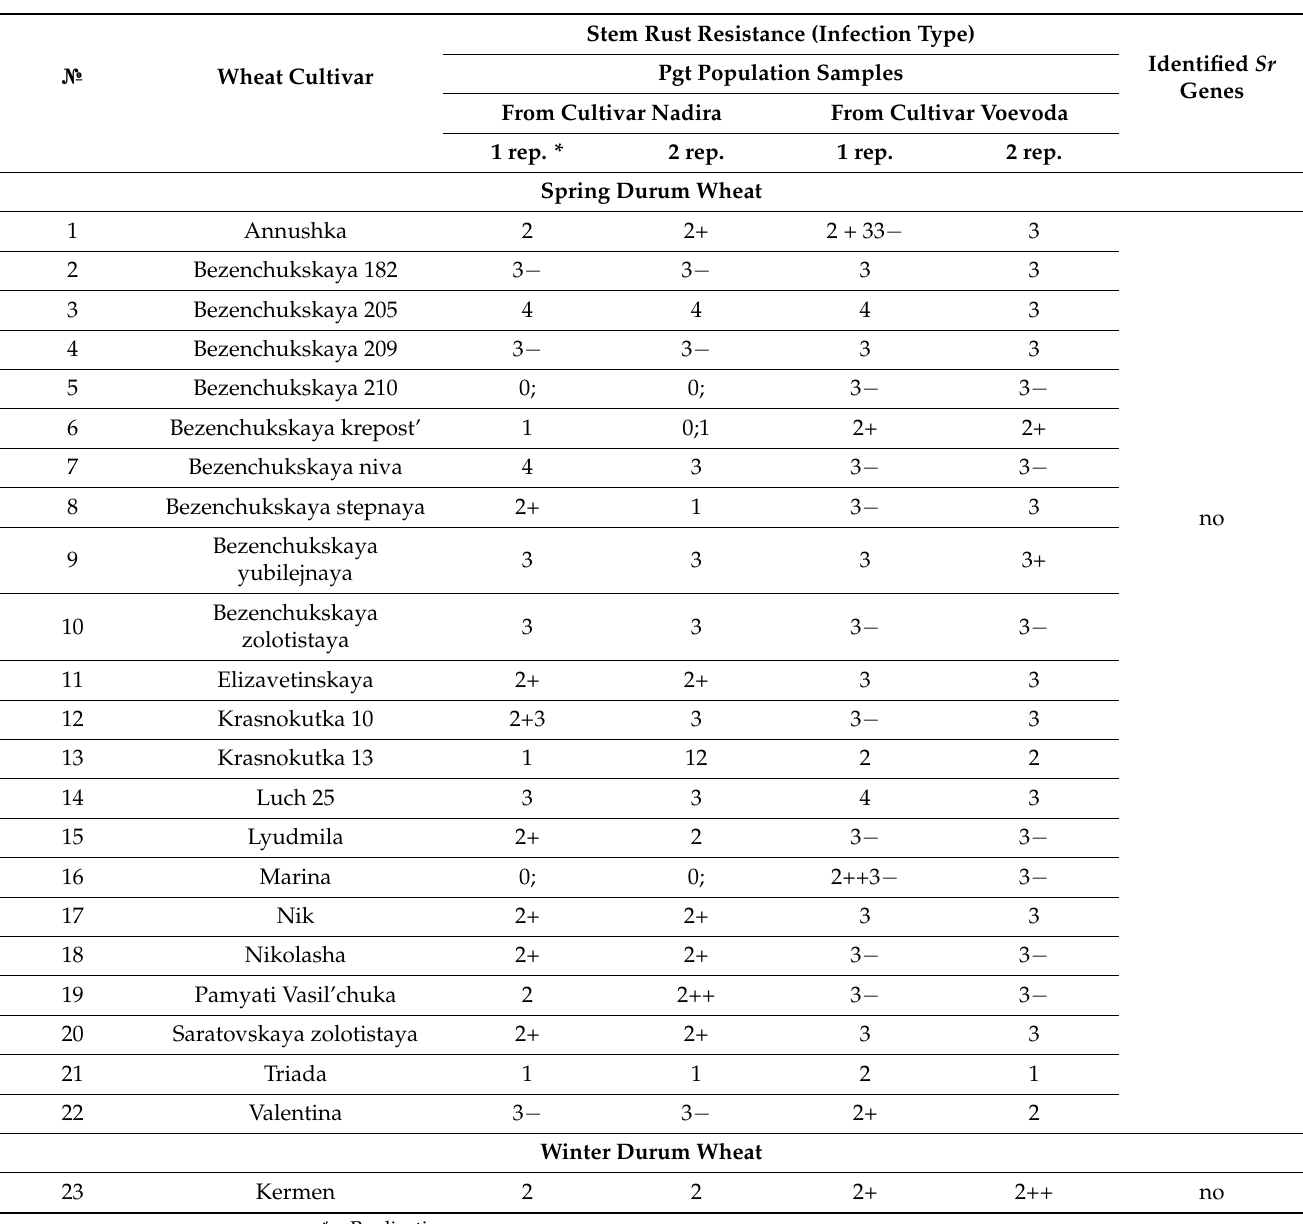
Table 2. Evaluation of resistance to stem rust and identification of Sr genes in durum wheat cultivars in the Volga